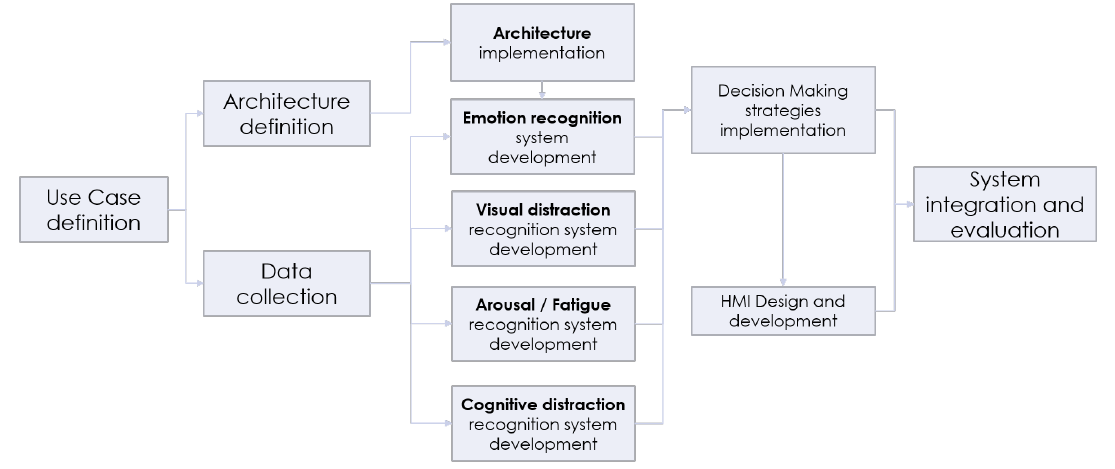
Figure 8. Implementation process of the Driver Complex State (DCS) monitoring